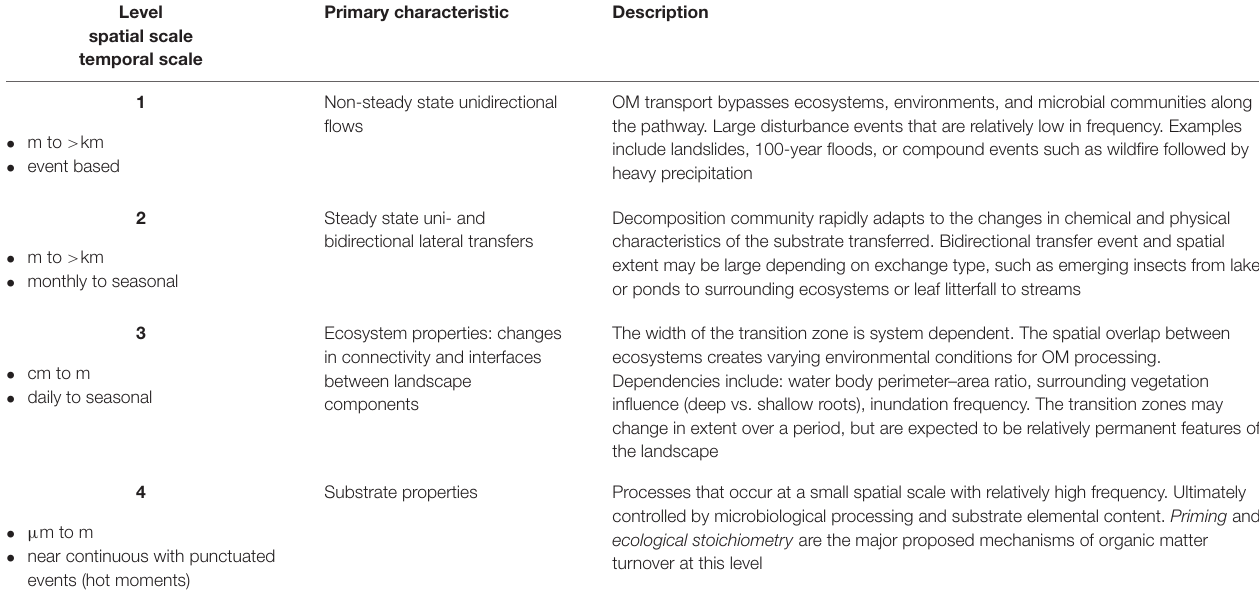
TABLE 1 | Spatio-temporal hierarchical model